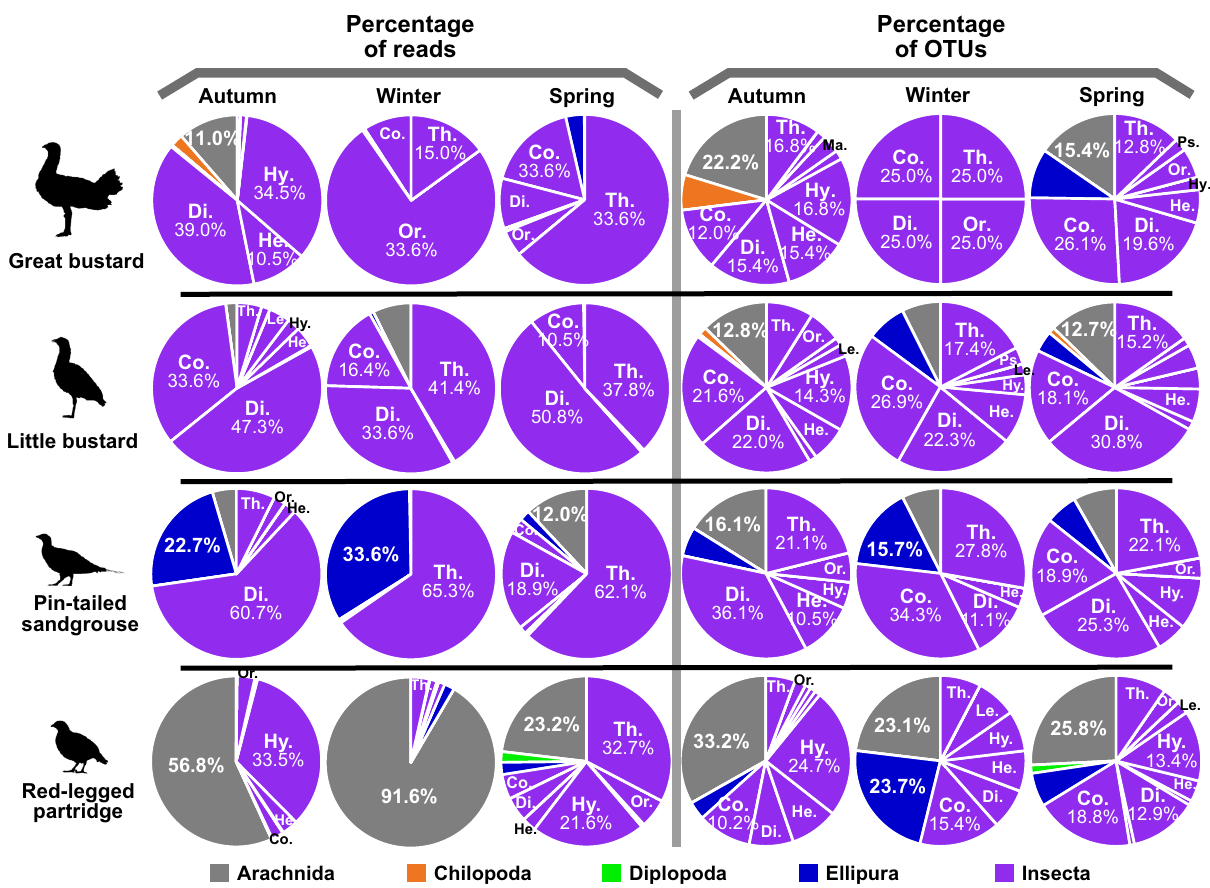
Figure 7. Mean percentage of reads (a measure of abundance) and OTUs (a measure of richness) of each phylum of Arthropoda present on the diet of great bustard, little bustard, pin-tailed sandgrouse, and red-legged partridge in autumn, winter, and spring, with phylum Insecta data broken down into orders. Percentages > 10% are detailed numerically. Among Insect’s orders, those with a percentage > 2% are identified. For great bustard and red-legged partridge, only one flock was sampled in winter so no SDs are